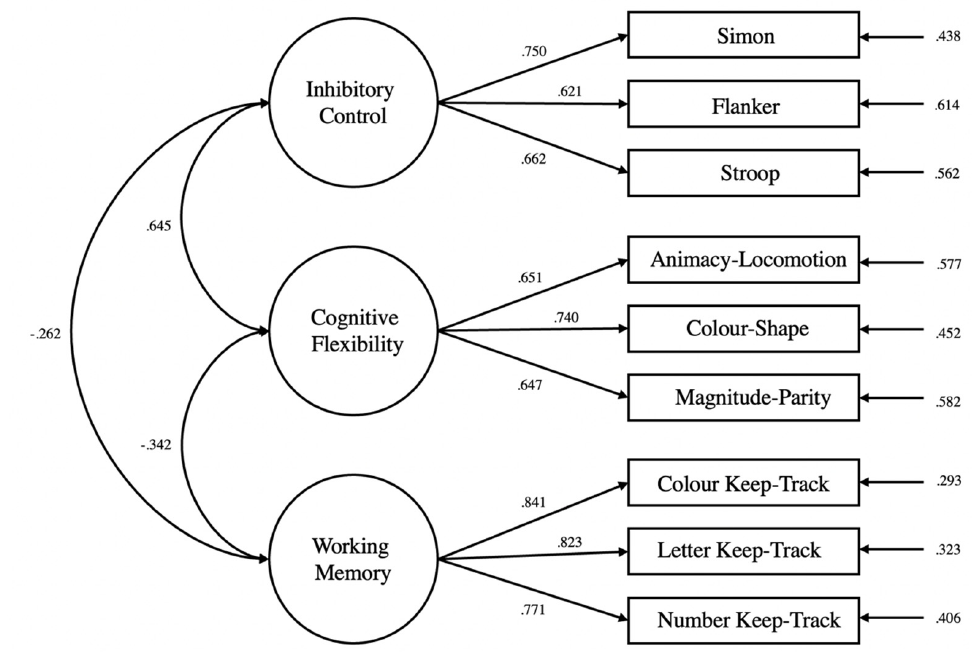
Figure 2. Confirmatory factor analysis of three-factor model of executive functions. Circles represent latent variables while boxes represent manifest variables (tasks). Single-headed arrows connecting latent variables to manifest variables represent standardised factor loadings. Double-headed arrows connecting latent variables represent latent intercorrelations. Single-headed arrows on the right of the figure represent error terms. All correlations and loadings were significant at the 0.05 level.